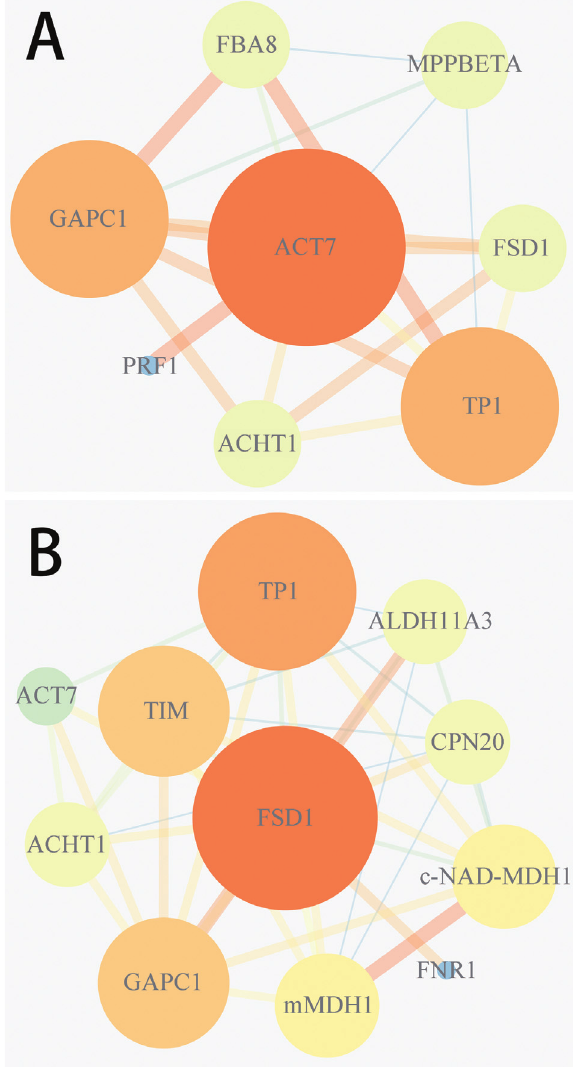
Figure 5 - Schematic representation of the protein-protein interaction net- work of the differential proteins in the bnclv-like that interact with act7 (a) and fsd1 (b), respectively. proteins with larger numbers of interacting pro- teins are represented by a larger circle size and color depth. The line width represents the reliability of the predicted interaction between two proteins, whereinteractionscontainingmoreevidencearethicker.Thenetworkwas initially constructed from Bnclv-like differential proteins using the STRING database and reconstructed by